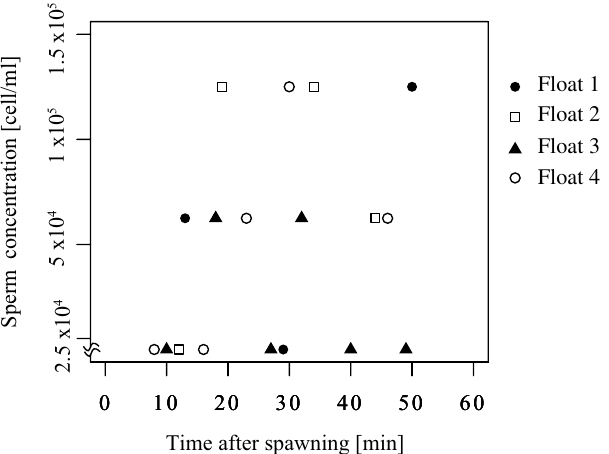
Figure 2. Time course of sperm concentration after the spawning in situ. Sperm concentrations were measured from seawater collected at 9 min intervals after the floats were released. Floats were released from the spawned colony approximately 10 min after they started releasing gametes. Water was collected for six times for Float 1 and four, five times for Float 2, and four times for Float